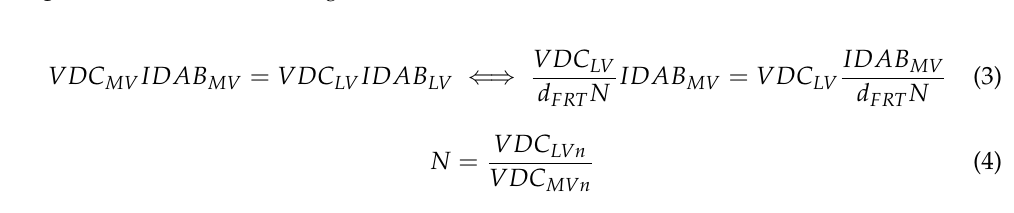
Figure 4. DC-DC converter stage